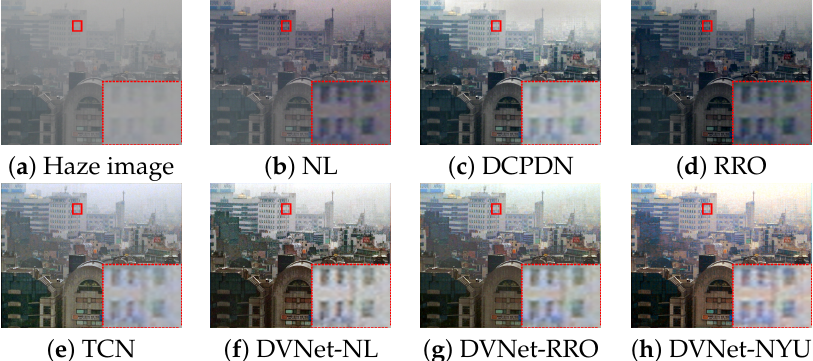
Figure 7. Dehazing results using real-world dataset: The red desh-shaped box denotes a zoomed region in the red box.